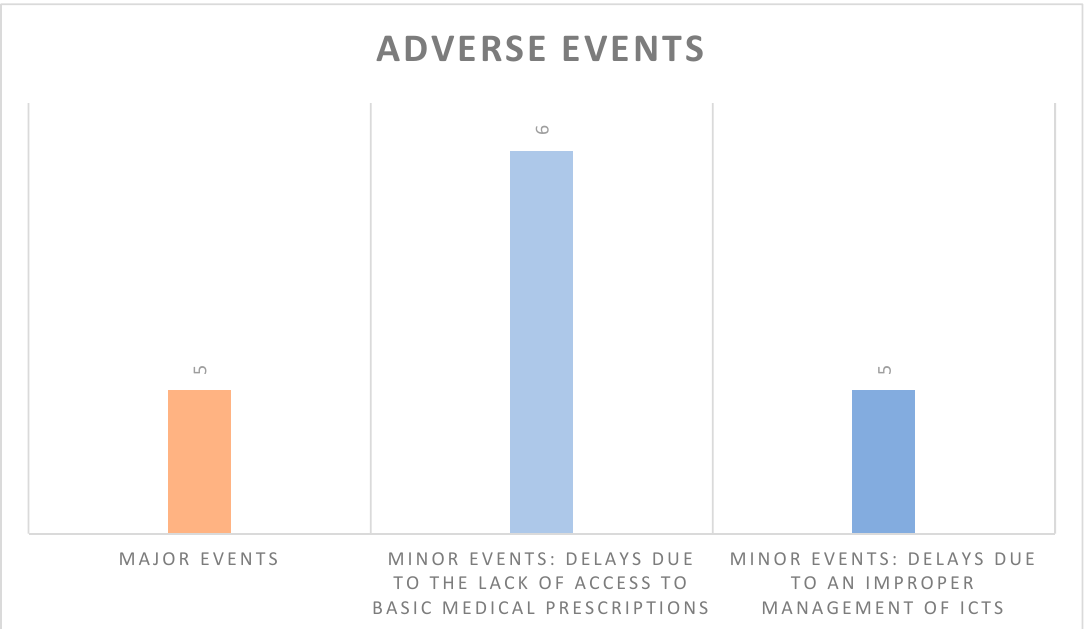
Figure 2. The total number of adverse events was 16/3828, 5 of which classified as major events and 11 as minor events.